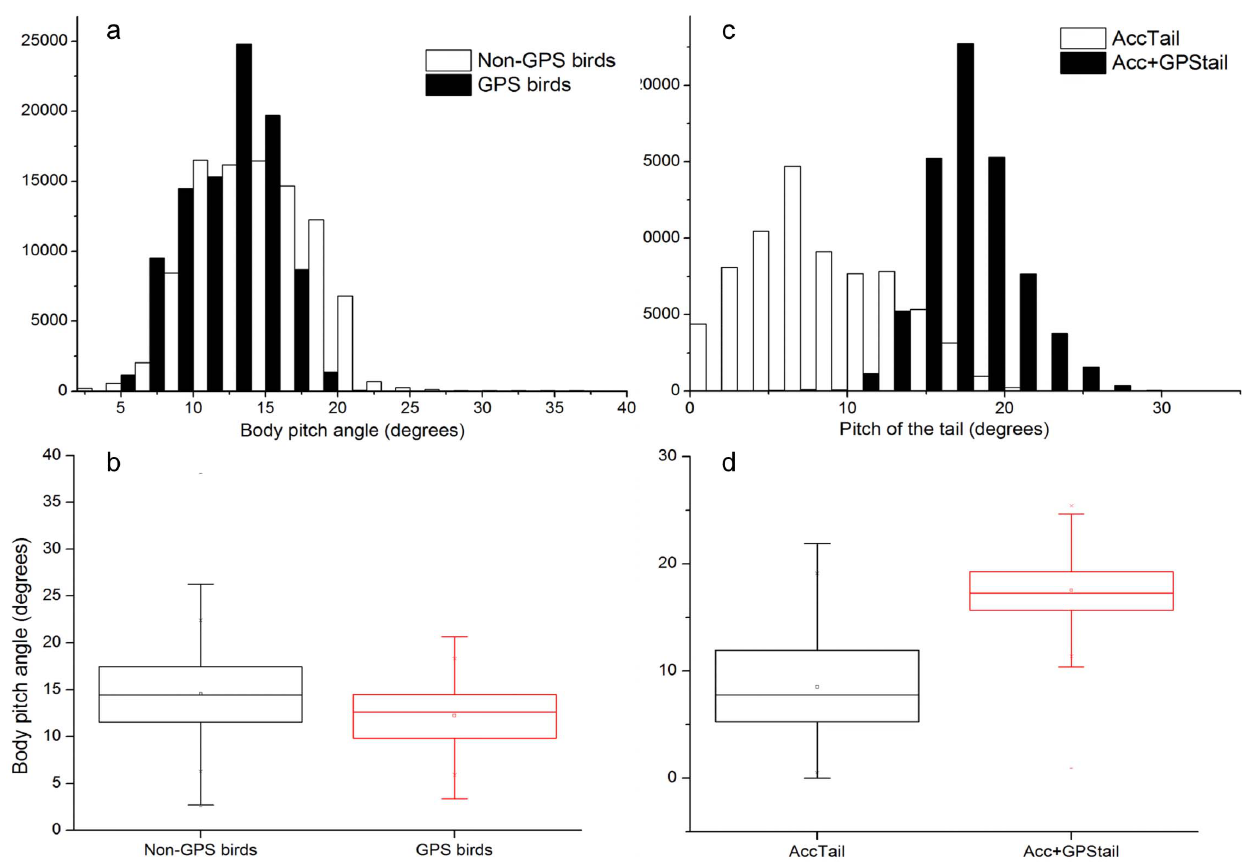
Figure 6. Differences in the flight angle of gannets with or without GPS. Frequency distributions (a, c) and box plots (b, d) of the body pitch angle of gannets (see text for full explanation) calculated over 10 minute flight period and while carrying different payloads at different positions. (a, b) Non-GPS birds (N=4) were fitted with 15 g accelerometers on their back as were GPS birds (N=4) which, in addition, carried a 30 g dummy GPS also under the tail. No significant difference in the body pitch angle was revealed between the 2 groups. (c, d) AccTail birds (N=3) were fitted with 15 g accelerometers under their tail as were Acc + GPStail birds (N=3) which, in addition, carried a 30 g dummy GPS also under the tail. The difference in the tail pitching moment between the 2 groups is significant (Mann-Whitney U test, z =294.9, P ,